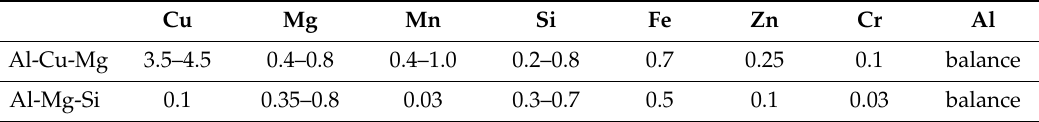
Table 1. Chemical compositions of Al-Cu-Mg and Al-Mg-Si